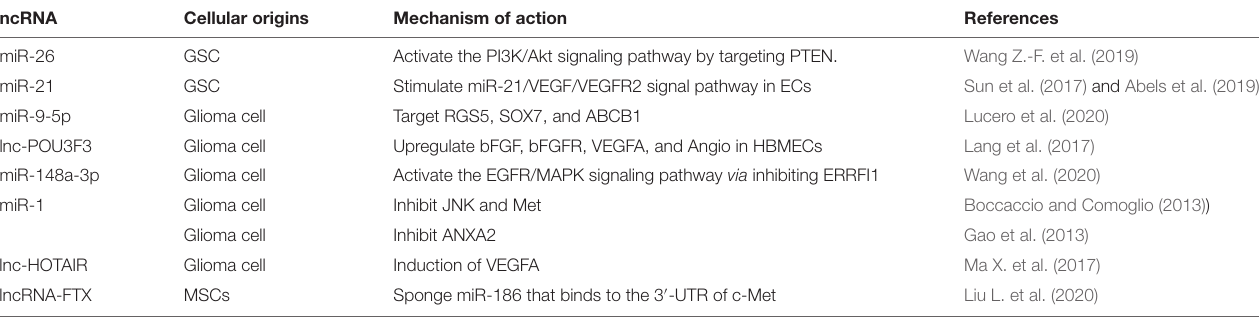
TABLE 5 | ncRNAs in EVs from different cellular origins that regulate angiogenesis in